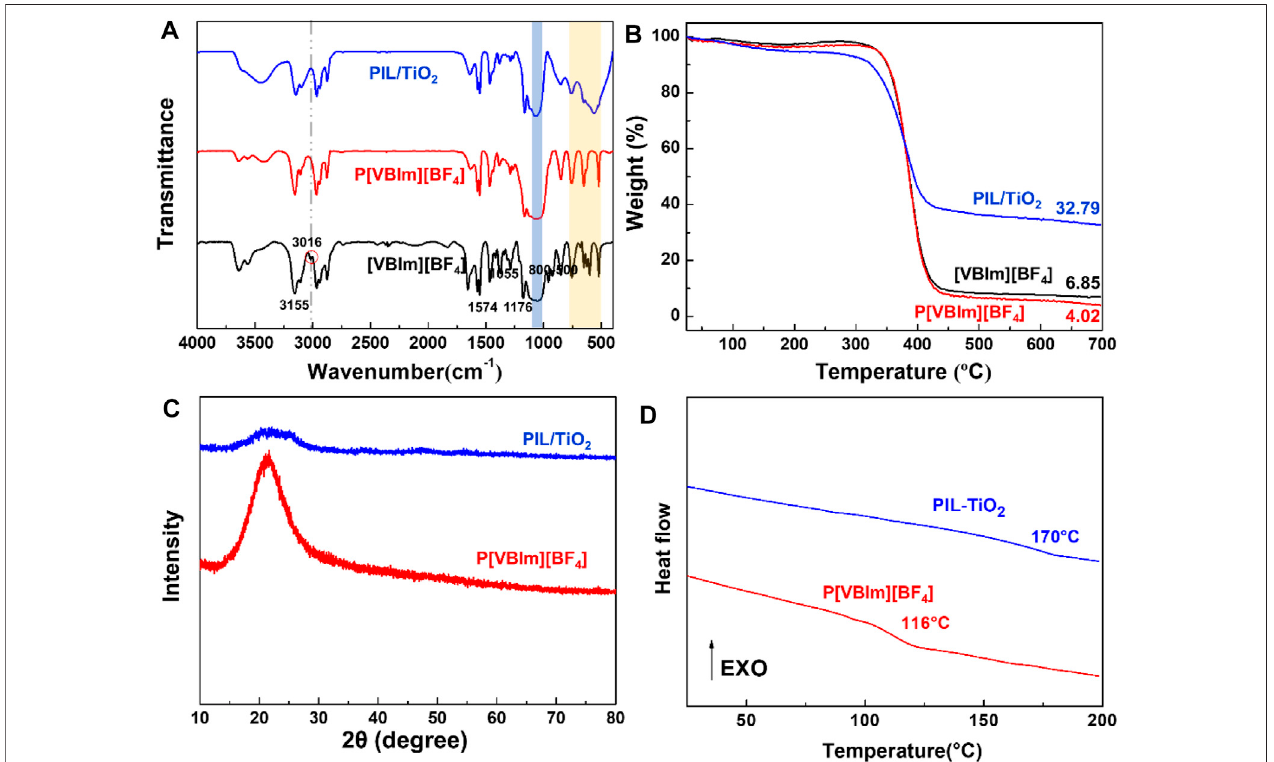
FIGURE 3 | FT-IR spectra (A) , TGA curves (B) , XRD patterns (C) , and DSC curves (D) of (VBIm)(BF 4 ) (IL), P(VBIm)(BF 4 ) (PIL), and PIL/TiO 2 .